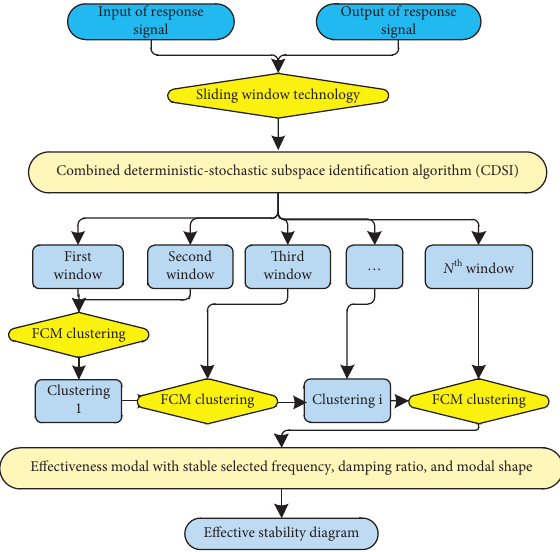
Figure 4: Flowchart of